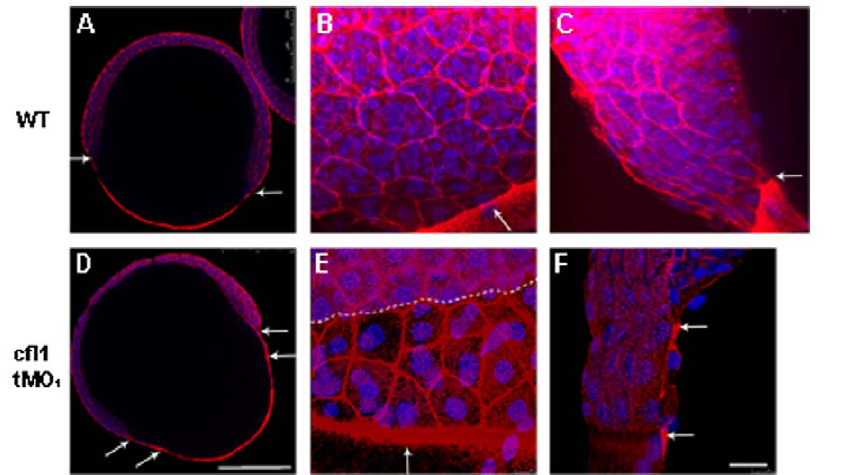
Figure 4. Knockdown of cfl1 enhances the filamentous actin (F-actin) formation and attenuates adhesion between the EVL and the DEL. Embryos at the 65% , 70% epiboly stage were fixed, stained with rhodamine phalloidin and DAPI to reveal F-actin and nuclei, respectively, under confocal microscopy. Confocal images of whole-embryo sections at a lower magnification are shown for untreated (A) and cfl1 tMO 1 -injected embryos (B). In the untreated embryo (A), an arrow indicates synchronous leading edges of EVL and DEL whereas distinctly separated leading edges are obvious as pointed by arrows in cfl1 tMO 1 -injected embryos (B). At a higher magnification (B, C, E, F), F-actin was more condensed at the boundaries of blastomeres and the margin of blastoderm (arrows) of cfl1 morphants (E) compared to untreated embryos (B). The progression of the EVL margin (arrow) was more advanced than that of DEL (dashed line) in cfl1 morphants (E) compared to that of untreated embryos (B). From the side view (C, F), the EVL margin (upper arrow) was clearly advanced 2 cells ahead of DEL (lower arrow) in cfl1 morphants (F) that was not seen in untreated embryos (C). Scale bars: 25 m m for A and D; 250 m m for B, C, E, F.